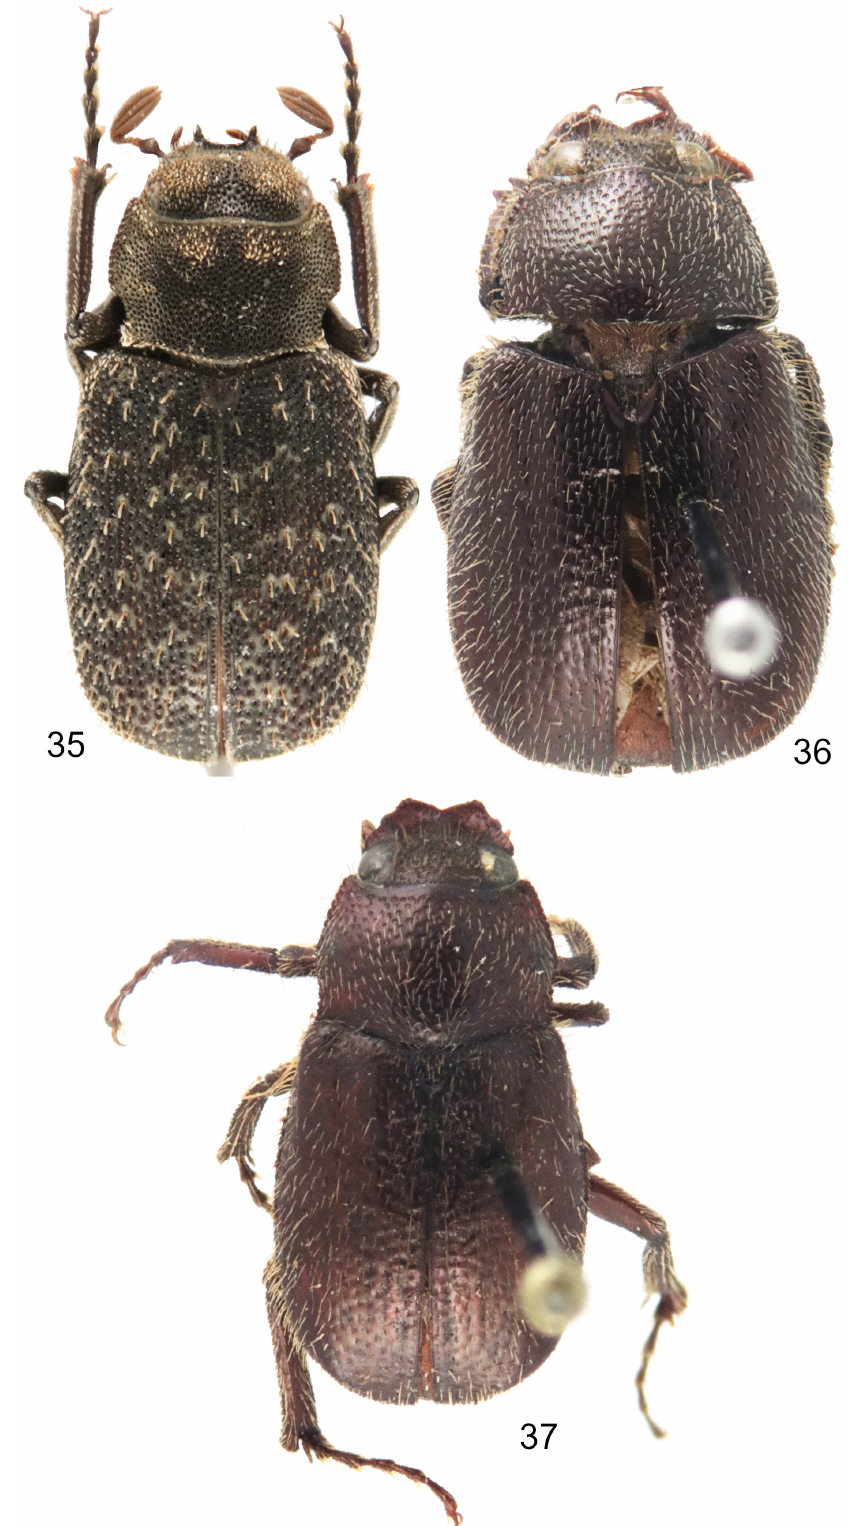
Figs 35–37. Papuan Maechidius Macleay, 1819, habitus, dorsal view. 35 . M. dendrolagus sp. nov., holotype, ♂ (NHMB). 36 . M. esau Heller, 1914 (lectotype ♂ of M. setosus Moser, 1920; ZMHB). 37 . M. esau , lectotype, ♂ (SNSD). Not to